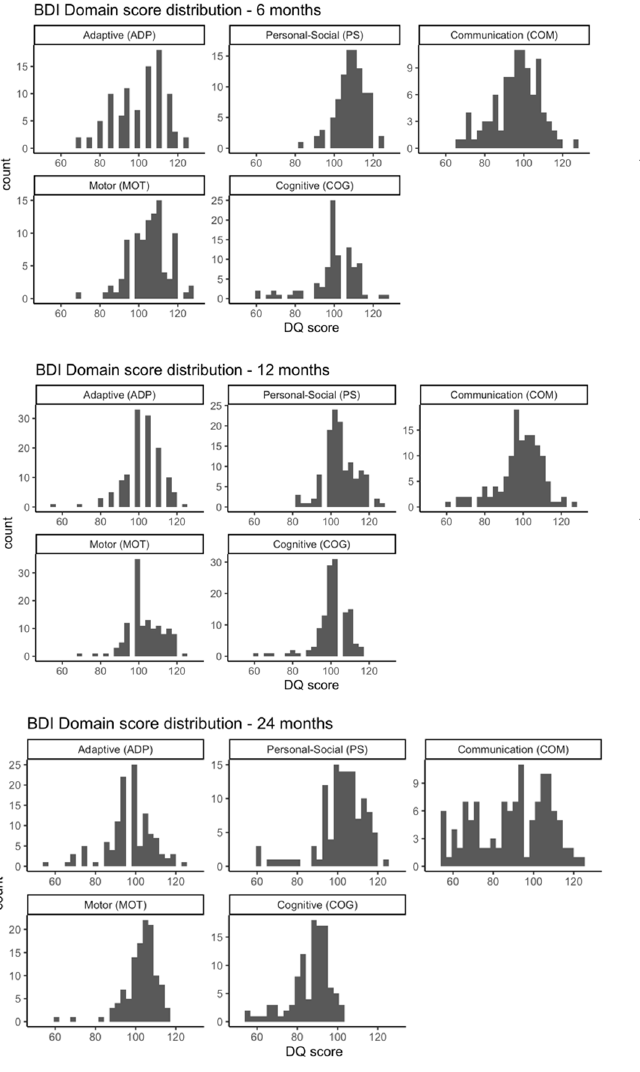
Figure 2. Histogram of BDI-2 domain and subdomain scores at 6 months, 12 months, and 24 months. Domain abbreviations: Adaptive (ADP), Personal-Social (PS), Communication (COM), Motor (MOT), and Cognitive (COG).